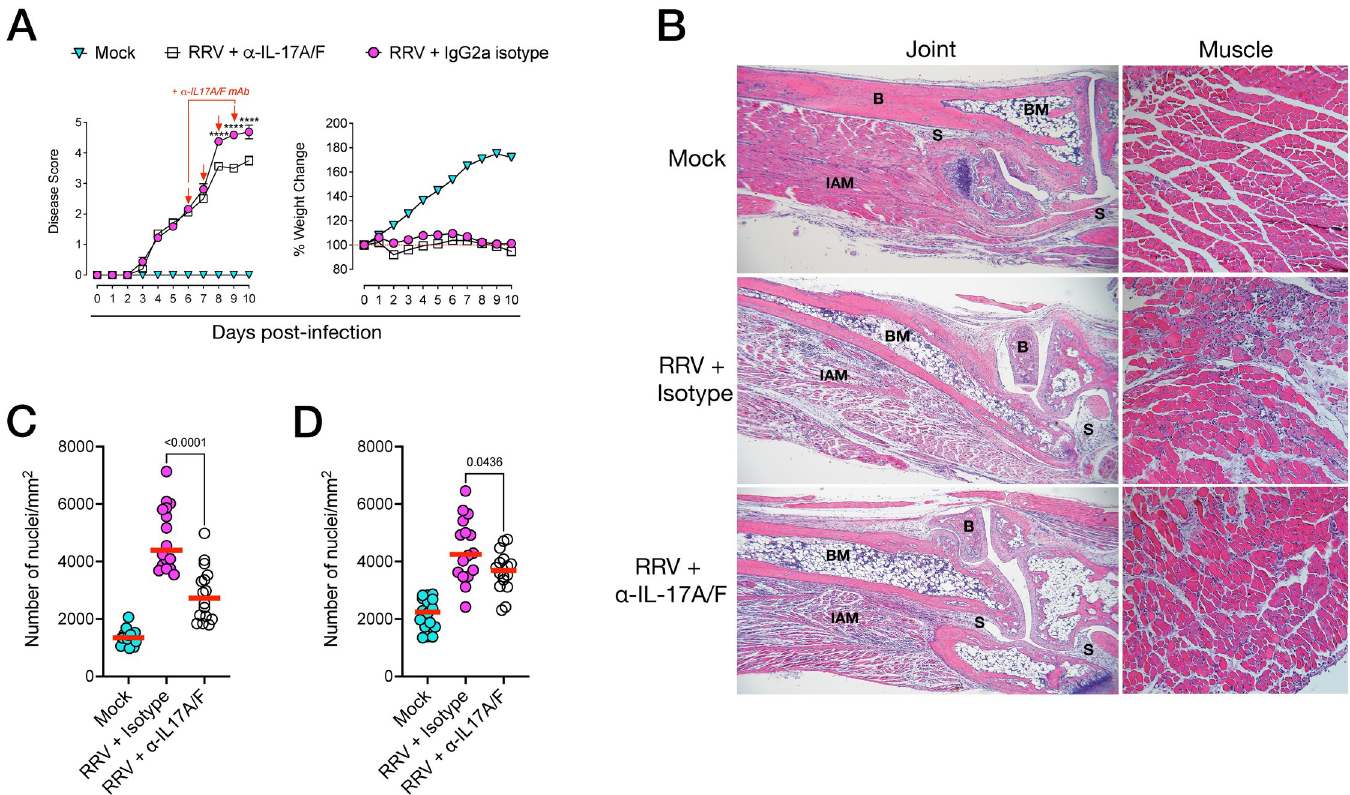
Fig 10. Therapeutic anti-IL-17A/F monoclonal antibody treatment reduces musculoskeletal disease in RRV infection. A) Disease score and weight loss kinetics of RRV-infected C57BL/6J mice treated with anti-IL-17A/F monoclonal antibody (mAb) or with IgG2a isotype from 6, 7, 8 and 9 dpi (red arrows show daily treatment). Data presented as mean +/- SEM. Statistically significant differences between groups determined by multiple t -test with Holm-Sidak correction. ���� , p < 0.0001. B) Hematoxylin and eosin (H&E) staining of paraffin sections of joint (left) and quadriceps muscle (right). B: bone; BM: bone marrow; S: synovium; IAM: interarticular muscle (left; 4X objective, right; 20X objective). C) Quantification of cellular infiltrates (automated nuclei count) of H&E–stained joint (interarticular muscle) and D) quadriceps muscle, as described in B) . Data are presented as the mean +/- SEM of 16 regions of interest (ROIs) per group. Data shows 2 independent experiments (n = 5 mice per group). Statistically significant differences between groups were determined with Mann-Whitney U test, p values indicated on graphs.